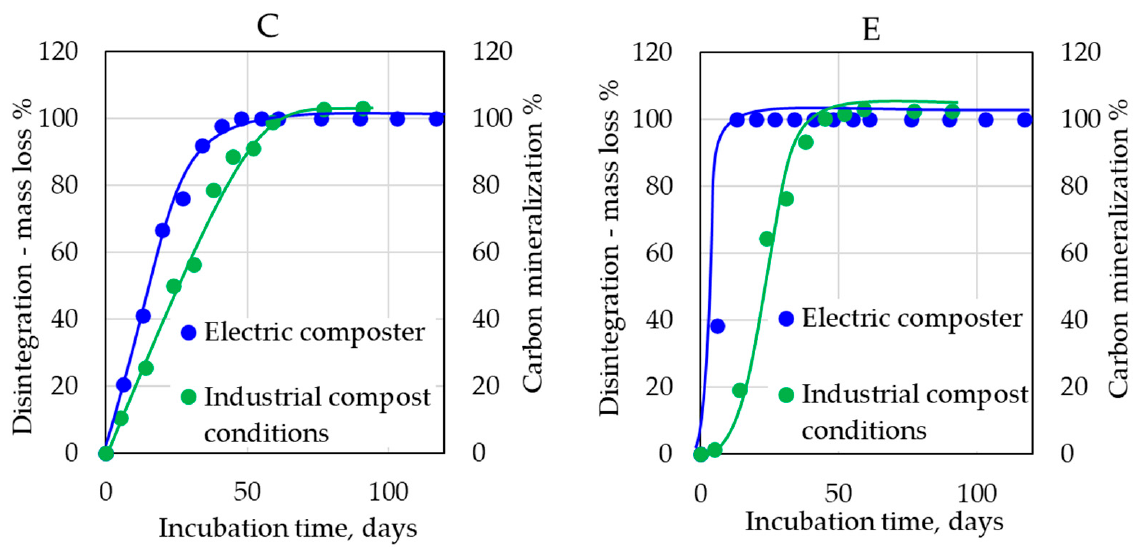
Figure 7. Comparison of biodegradation curves measured as CO 2 in industrial compost conditions (58 °C) for samples C and E and in home-compost conditions (28 °C) for sample E with disintegration curves obtained using an electric composter for samples C and E.